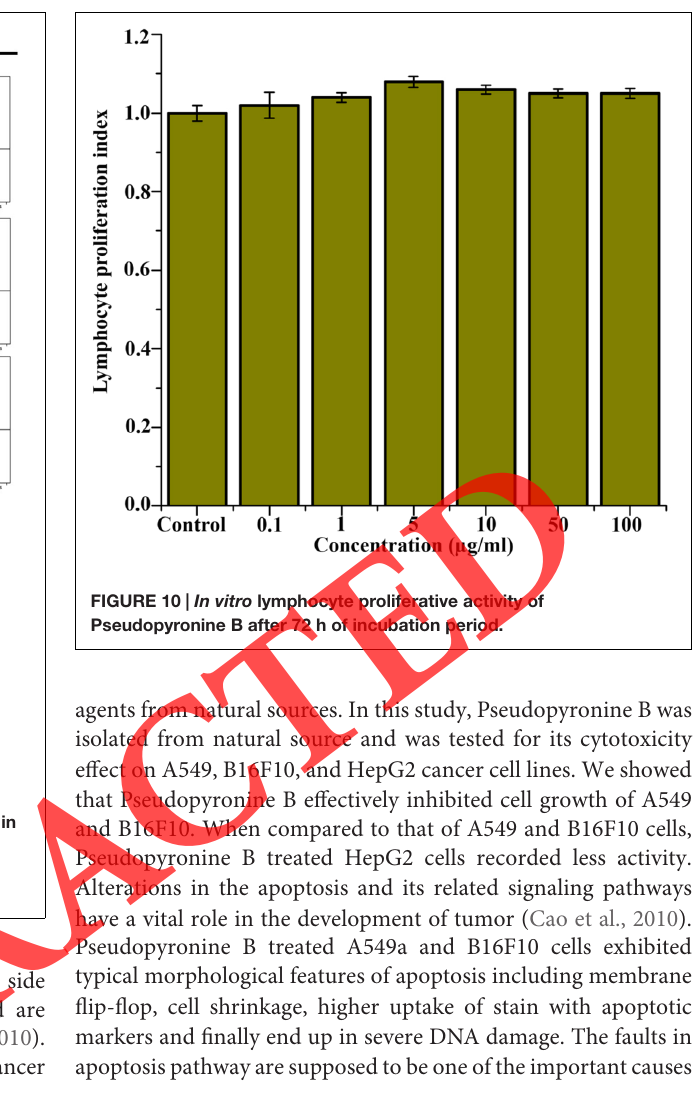
FIGURE 8 | Pseudopyronine B induce phosphatidylserine exposure in A549 and B16F10 cells. The cells were stained with annexin V-FITC and propidium iodide. Analyses were performed by flow cytometry. Each data represents mean ± SD from three independent experiments.